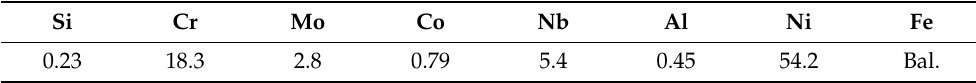
Table 1. GH4169 alloy powder composition